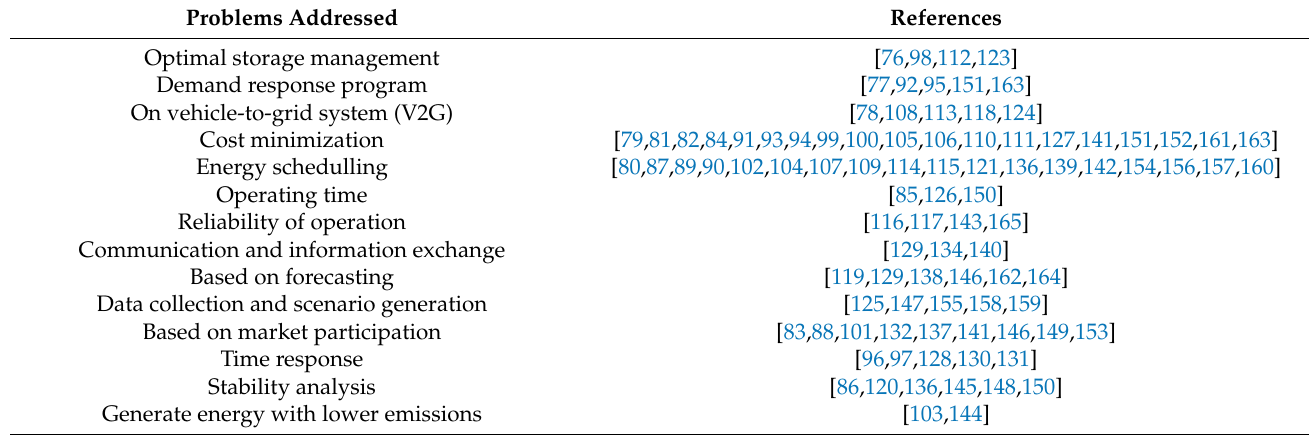
Table 10. The problem addressed in microgrid energy